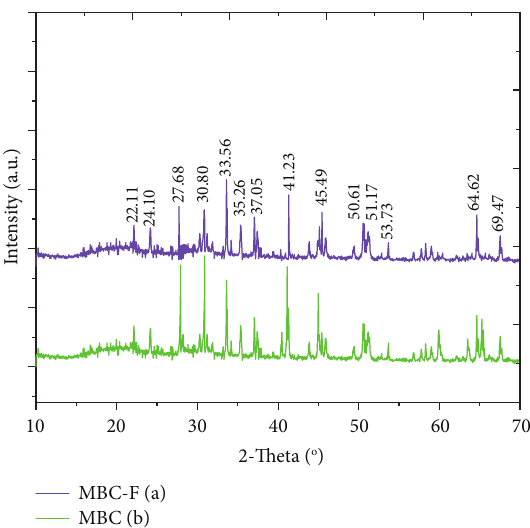
Figure 2: X-ray patterns for lanthanum doped magnetic BC before and after